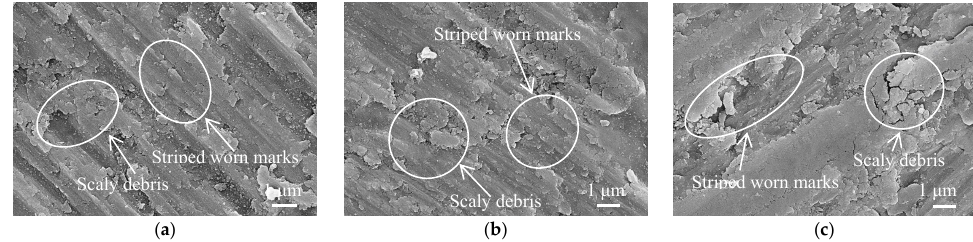
Figure 10. Morphologies of worn track on cold sprayed Al coatings after LR. ( a ) Wear load of 0.5 N; ( b ) Wear load of 1.0 N; ( c ) Wear load of 1.5 N.